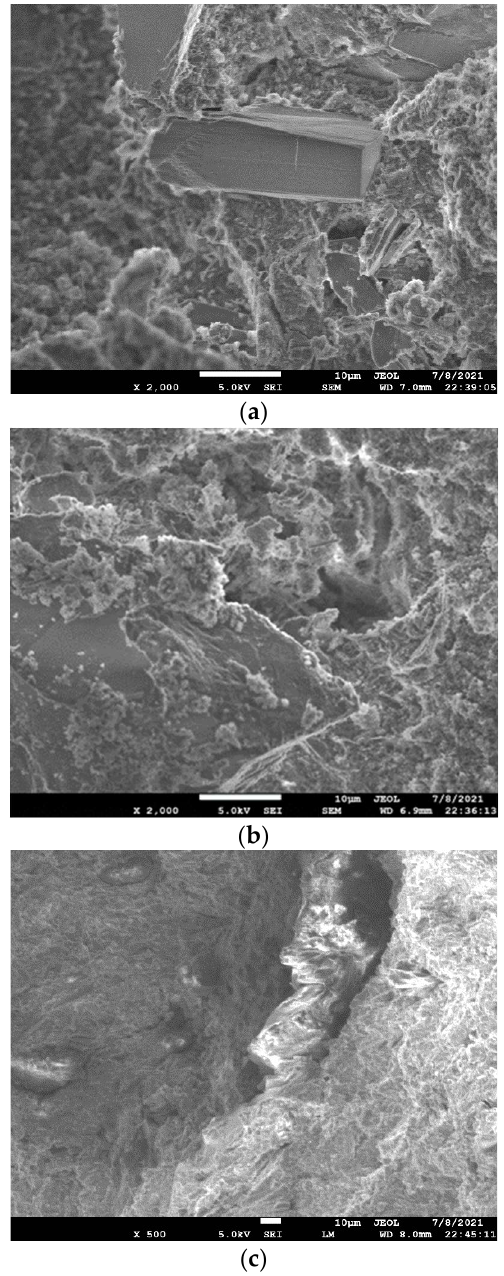
Figure 5. The microstructure of concrete at 0.45 w / c ratio (( a ). 0% metakaolin, ( b ). 10% metakaolin, ( c ). 20% metakaolin).